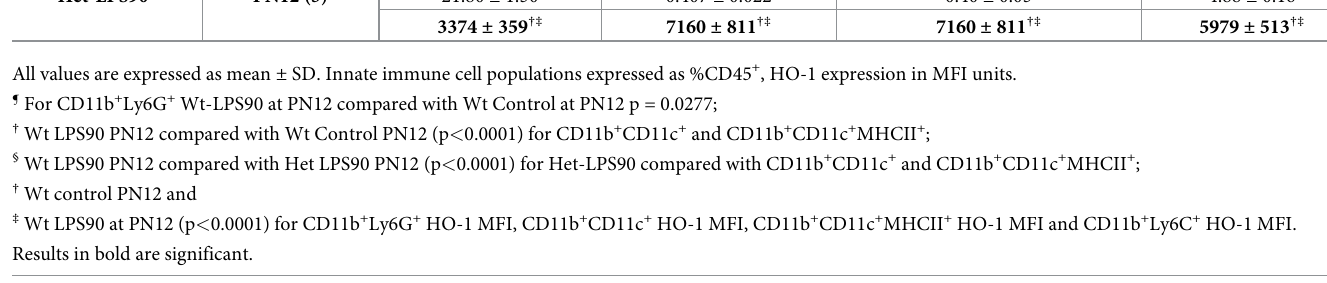
Innate immune responses in offspring at PN12 after maternal treatment with LPS The frequency of CD45 + cells (common leukocyte marker) were similar between spleens from LPS90-exposed Wt and Het pups at PN12 compared with age-matched Wt pups delivered from untreated dams (controls) (Table 1). A significant decrease in splenic CD11b + Ly6G +